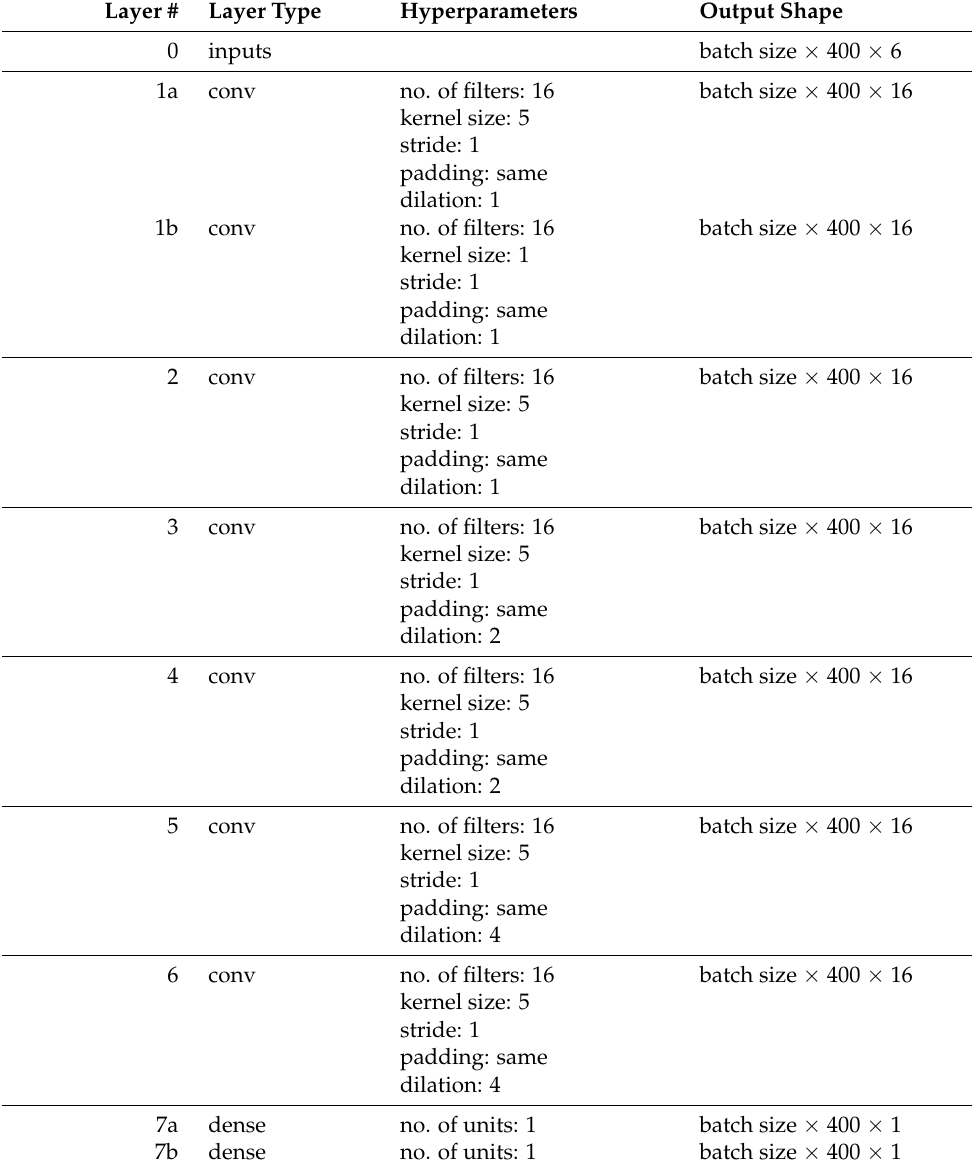
Table 4. Model layer